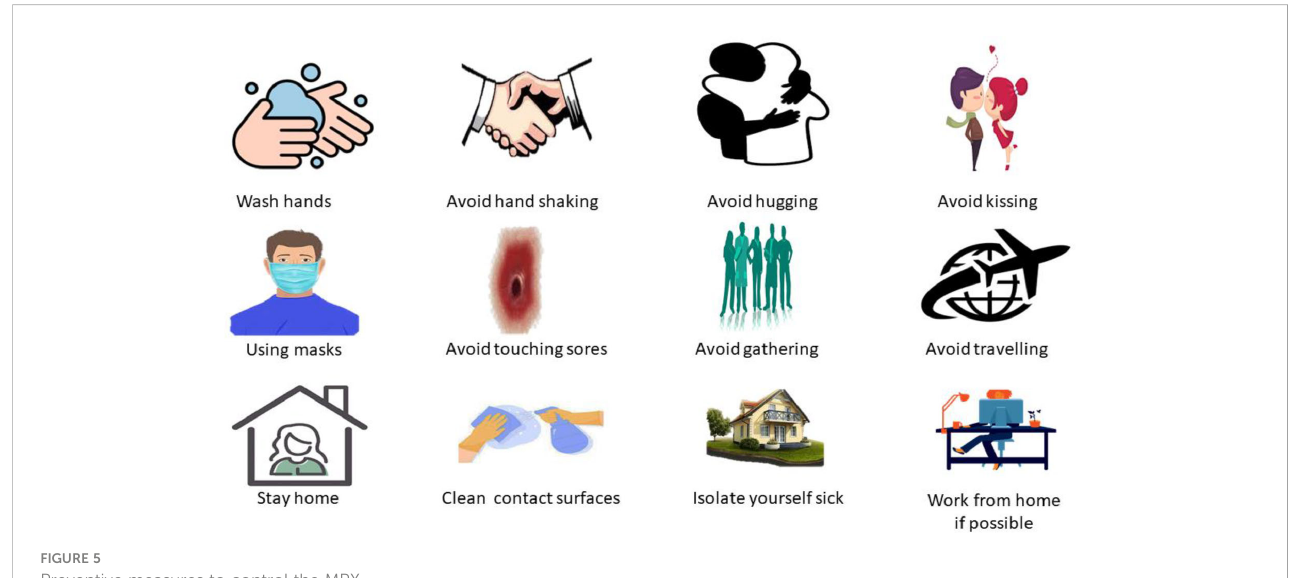
FIGURE 5 Preventive measures to control the